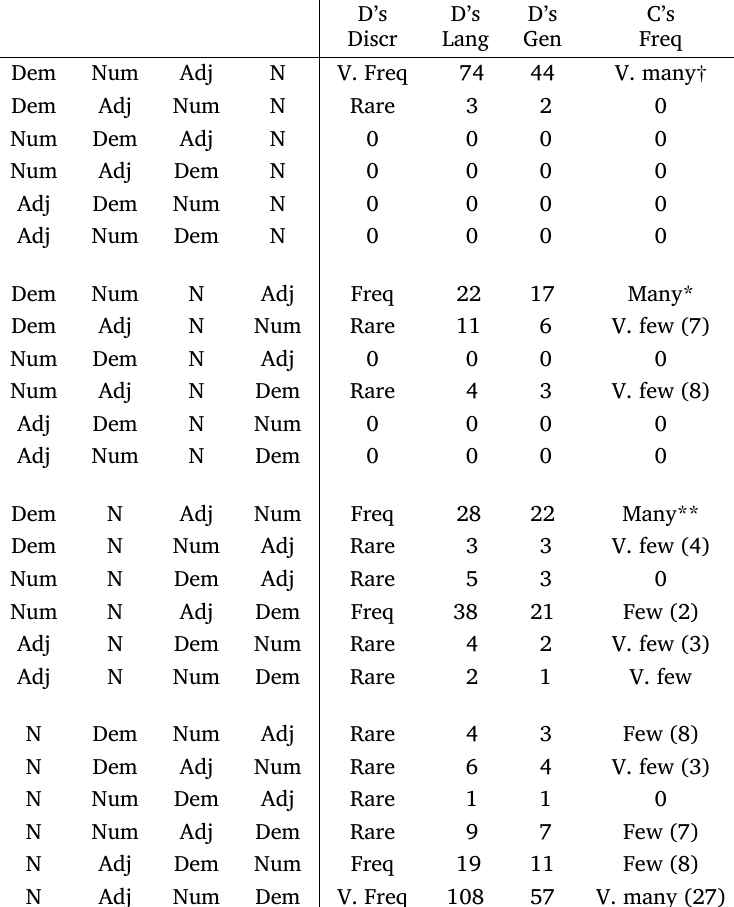
Table 1: Attested word orders of Universal 20 and their estimated frequencies. (See the text for more